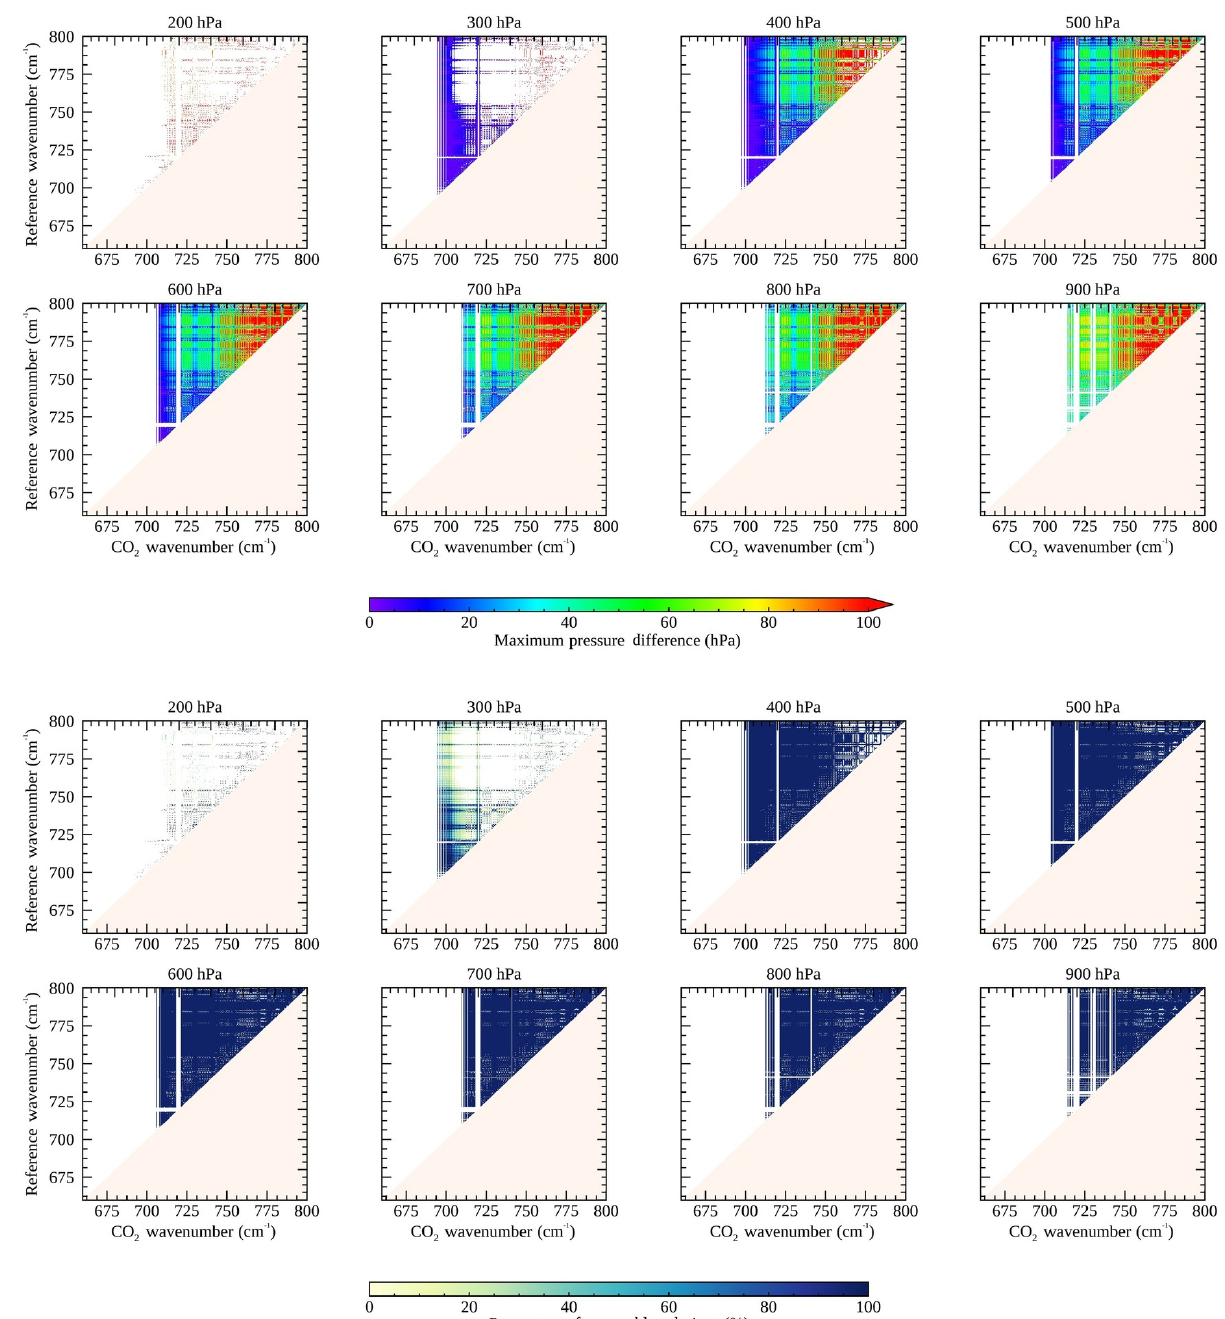
Figure A2. Same as Fig. A1 for a mid-latitude day